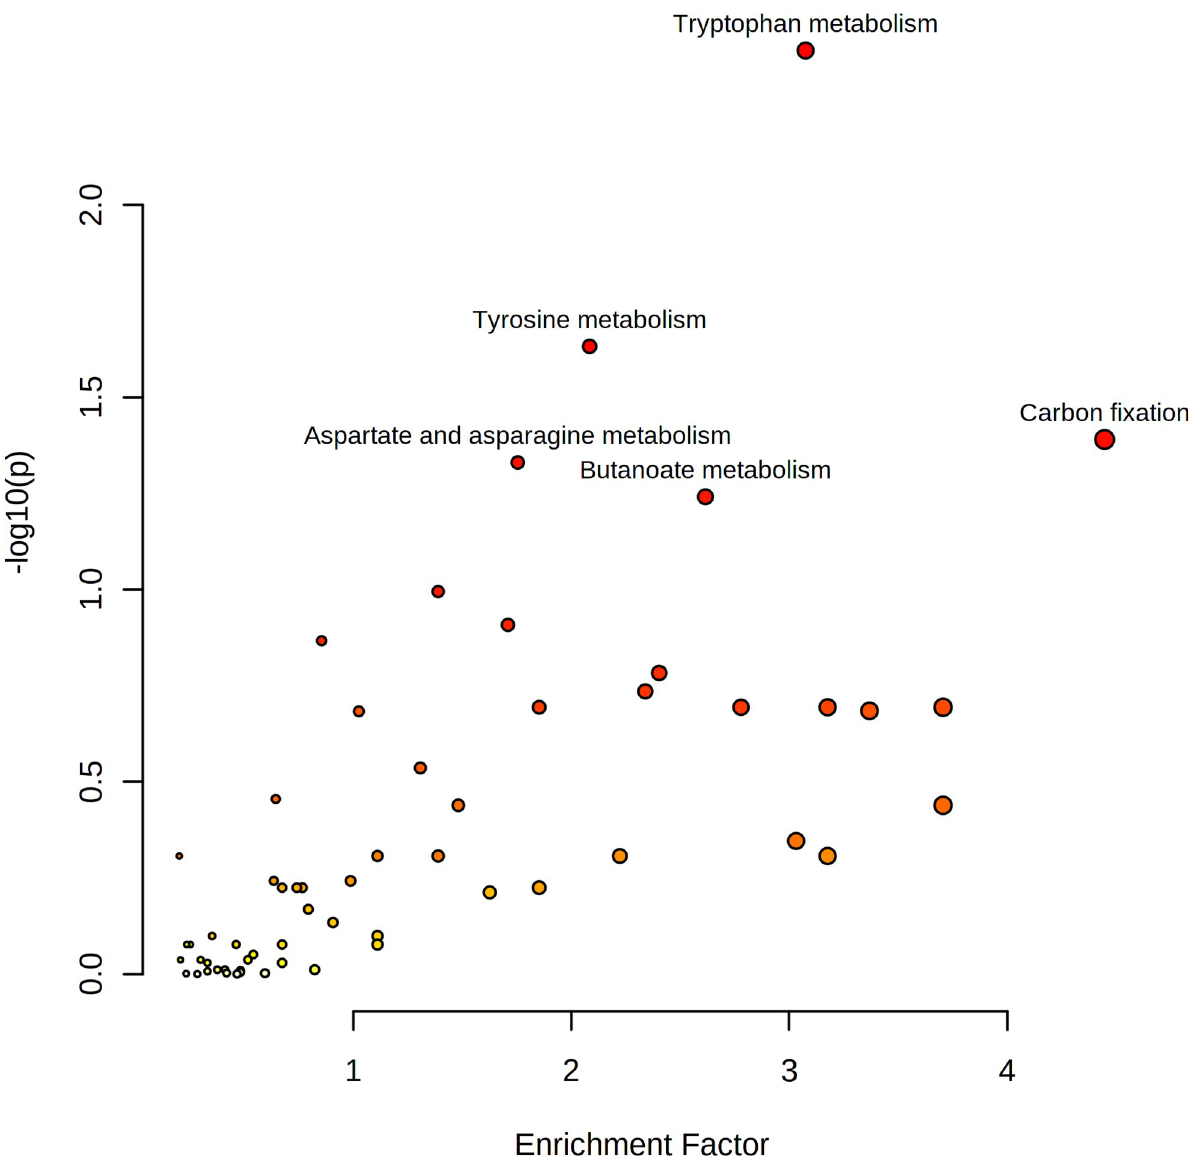
Fig 3. Pathway enrichment analysis of differential metabolites of pSS and healthy